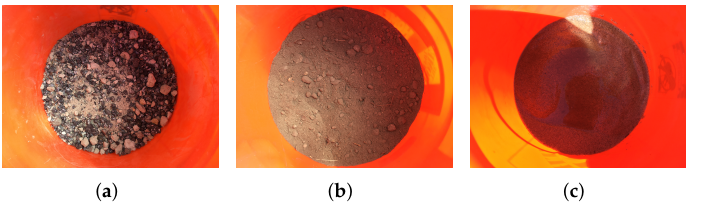
Figure 14. Sediment Samples: ( a ) Condition 1: Clay and pebble mixture; ( b ) Condition 2: Fine silt; ( c ) Condition 3: Beach sand.